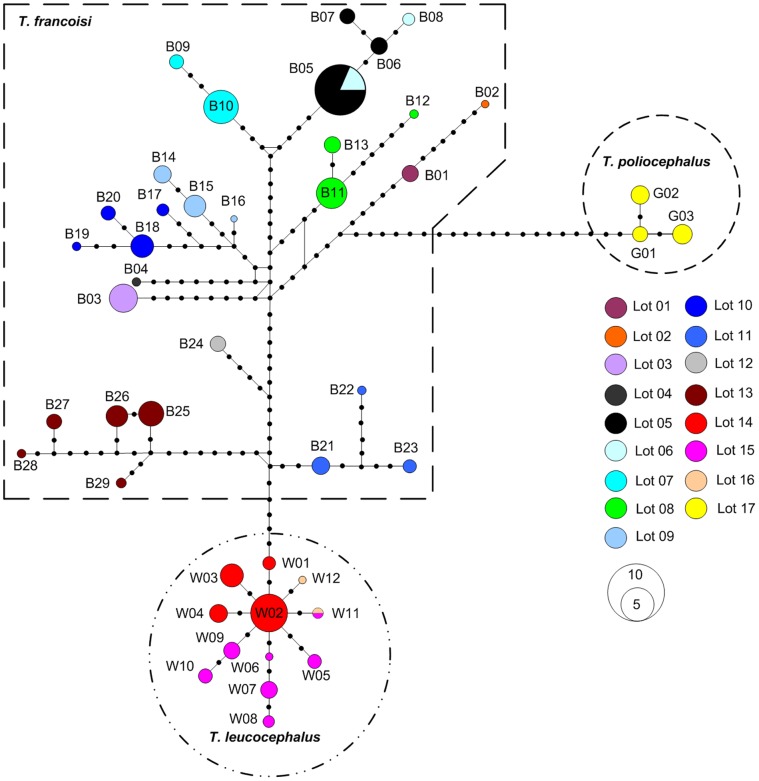
Minimum-spanning network for T. francoisi, T. leucocephalus and T. poliocephalus haplotypes.Each circle represents a haplotype and the diameter scales to haplotype frequency. Mutational steps are represented by black dots on lines connecting haplotypes. Sampling lots are presented as colored circles.